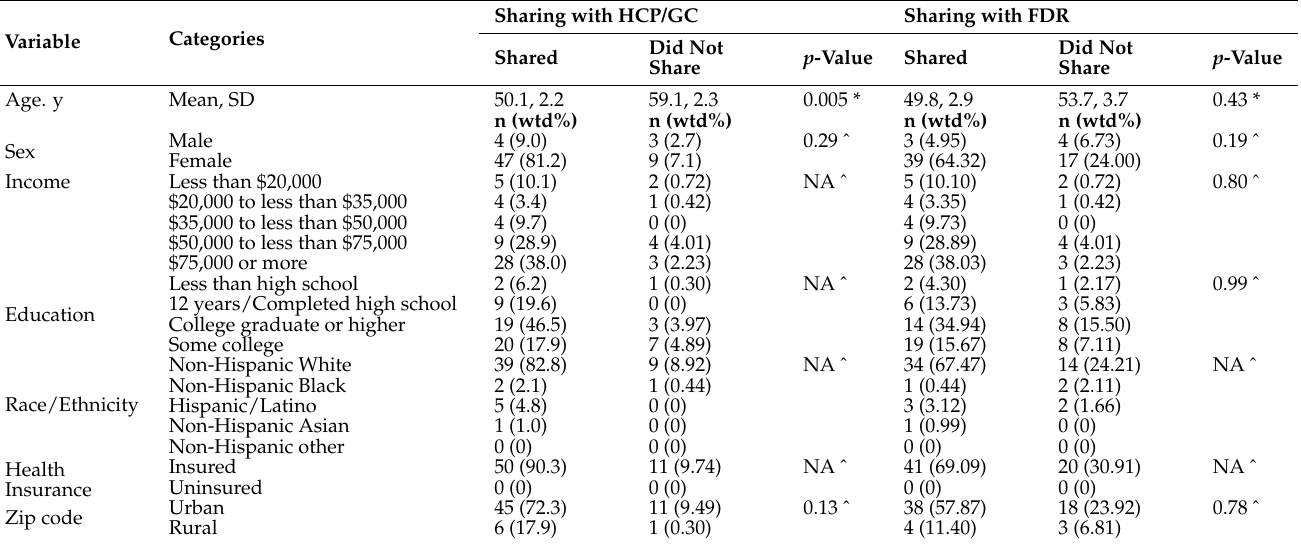
Table 3. Descriptive characteristics of individuals who shared results from genetic health risk testing.